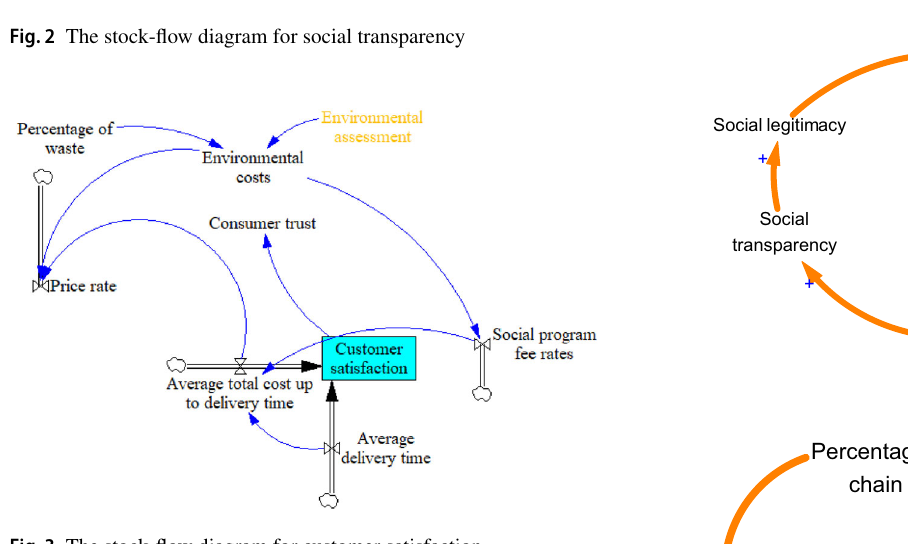
Fig. 3 The stock-flow diagram for customer satisfaction